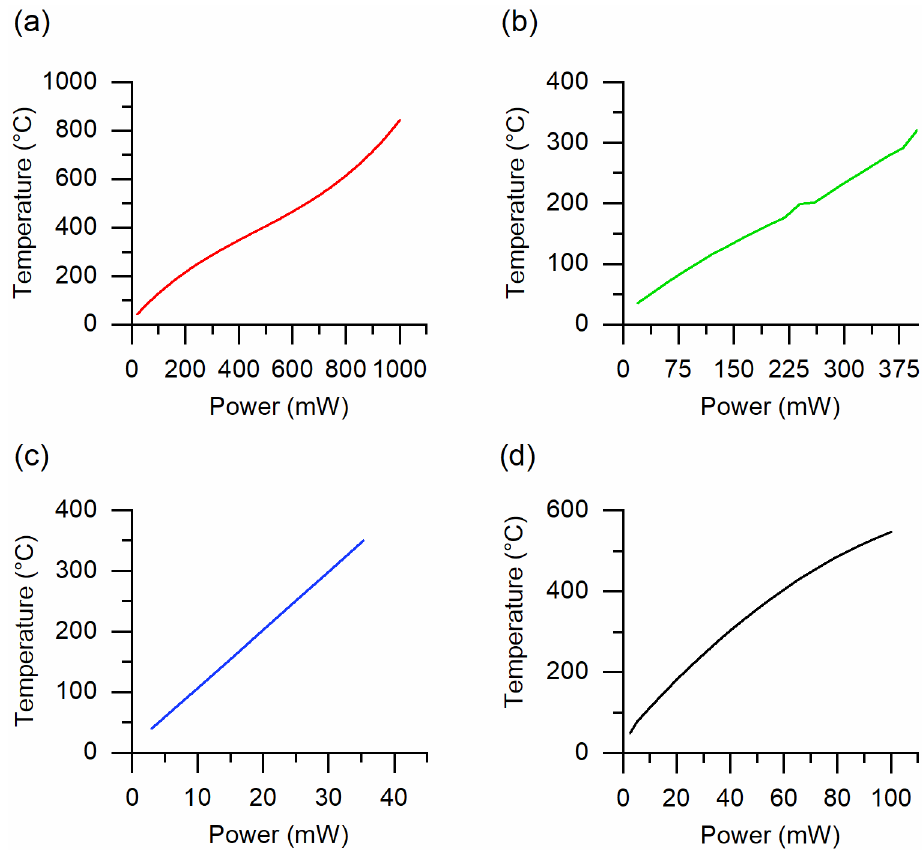
Figure 1. The operating temperature versus applied power calibration curves of substrates used in the fabrication of gas sensors at SENSOR lab: ( a ) alumina, ( b ) Kapton HN, ( c ) micro-hotplate manufactured by SAMLAB and ( d ) micro-hotplate E1 20:20, manufactured by AMS Sensor Solutions Germany GmbH.